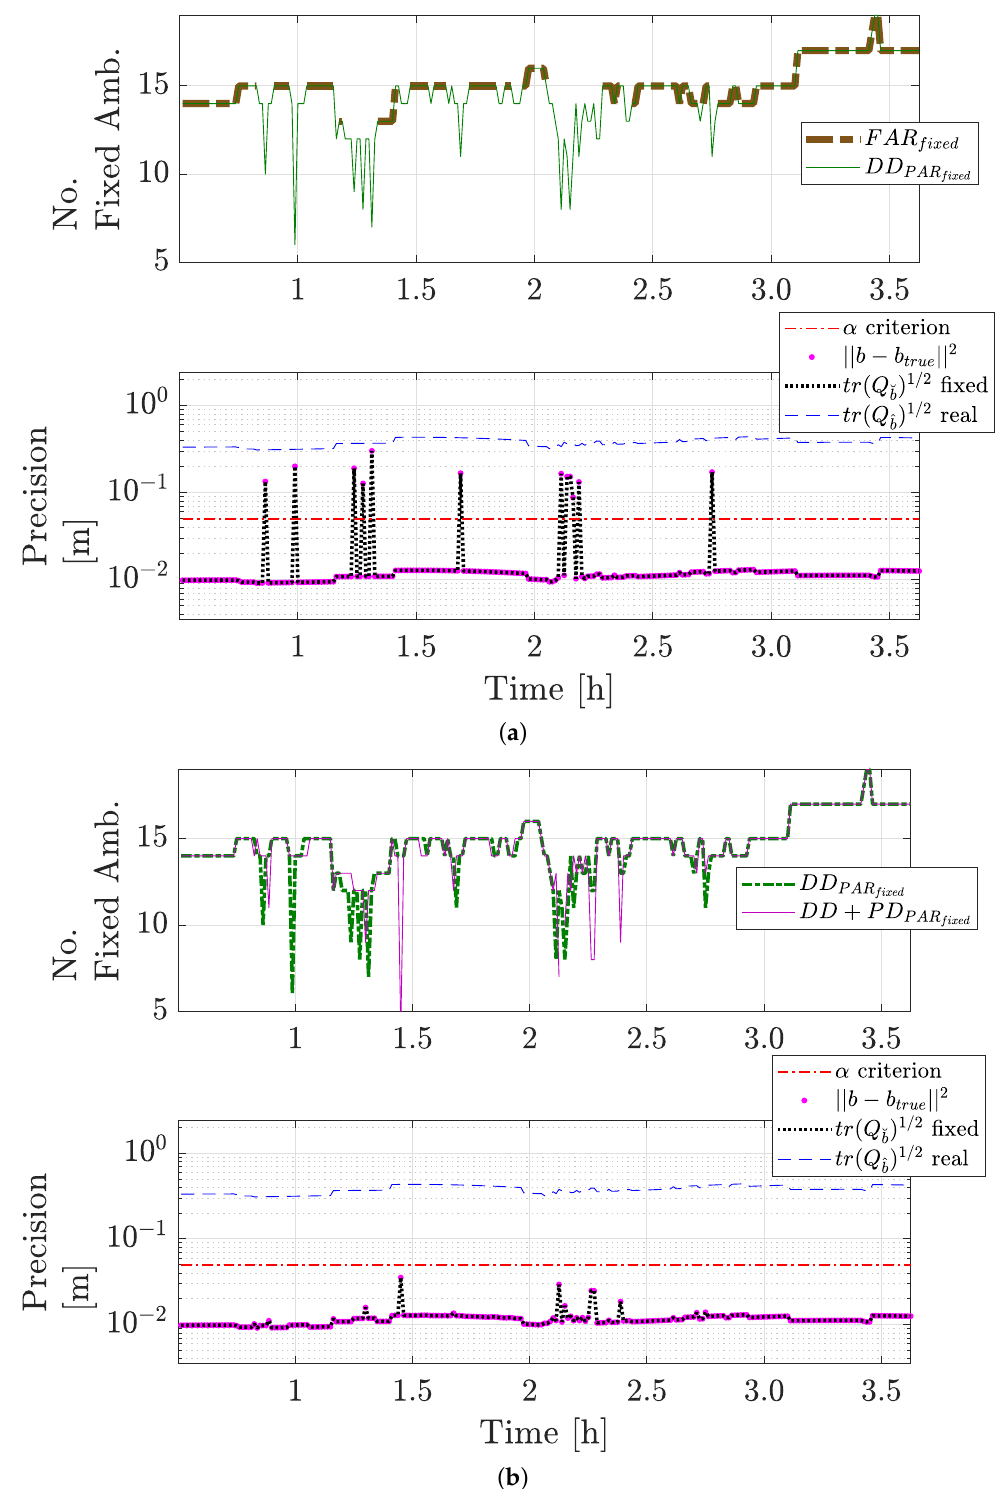
Figure 9. Comparative of success rate P s = 1 − P F . Number of fixed ambiguities and precision for FAR, Data-Driven PAR, and Data-Driven+precision-aided PAR schemes. ( a ) GPS (L1 + L2) + GAL (E1 + E5a) performance comparative for a DD-PAR scheme when FAR fails (no fixed solution). ( b ) GPS (L1 + L2) + GAL (E1 + E5a) performance comparative for the proposed DD+PD PAR scheme when FAR or DD-PAR fails (no fixed solution). Furthermore, PD-PAR guarantees a fixed solution whose fixed positioning errors (and precision) respect the criteria for minimum required positioning precision α